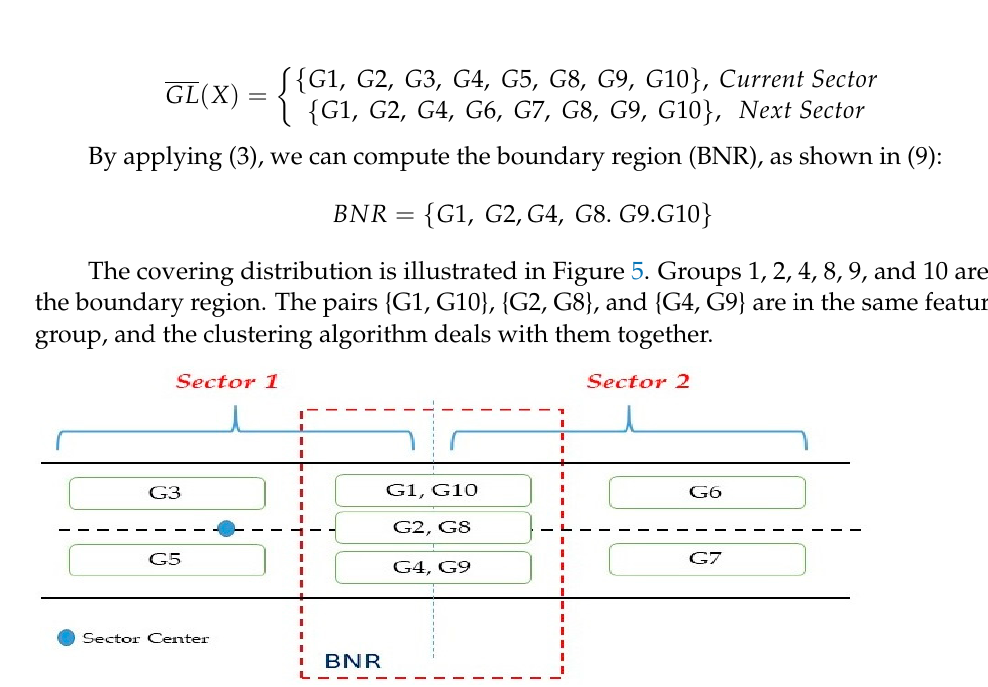
Figure 5. Rough set covering distribution.